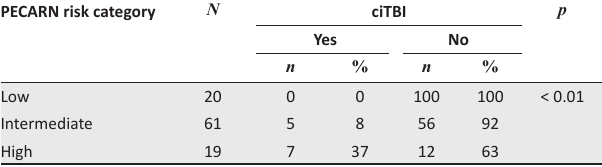
TABLE 3: Association between PECARN risk category and a clinically important traumatic brain